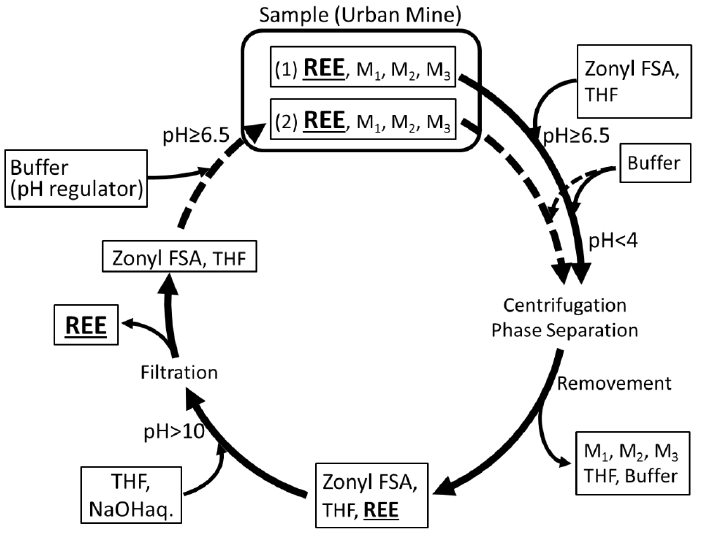
Figure 4. Separation and recycling system for rare earth elements using Zonyl FSA ® . REE: rare earth elements; M x : coexistent